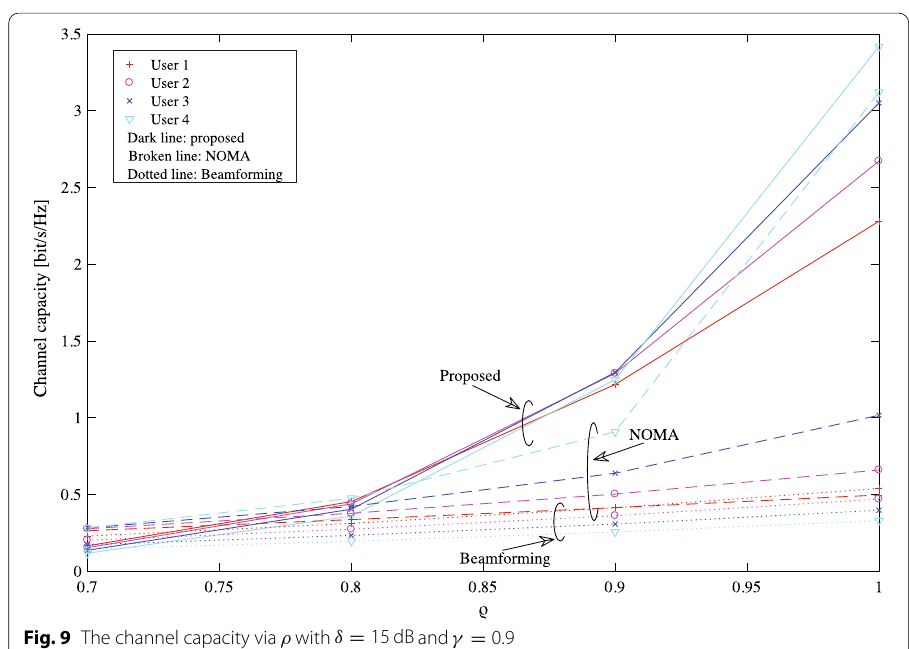
Fig. 9 The channel capacity via ρ with δ = 15dB and γ =